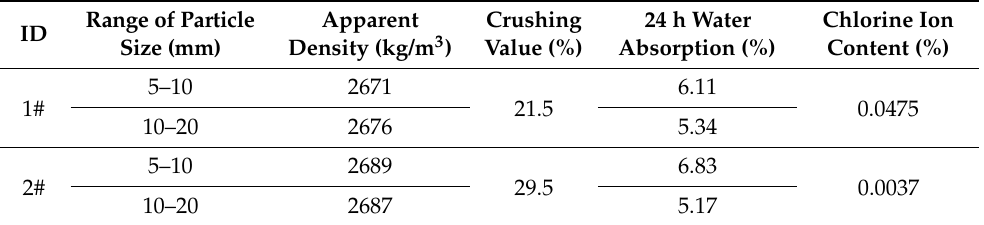
Table 1. Properties of the aggregates.